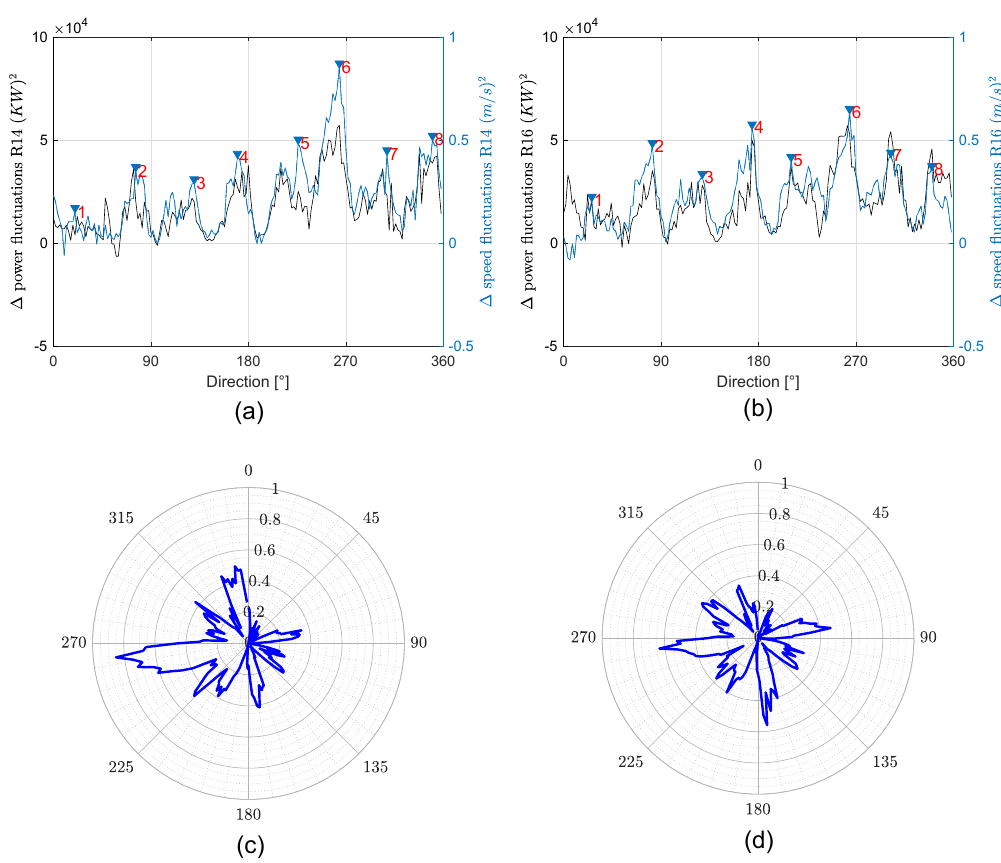
Figure 5. Mean fluctuation difference ( a,b ) between inner turbines and free-flow turbines for all wind directions and wind turbines R14 ( c ) and R16 ( d ), respectively. Left axis shows power fluctuations and right axis shows wind speed fluctuations. Polar plot of wind speed fluctuation difference for turbines R14 and R16, respectively. The radial axis is the difference of wind speed fluctuations [(m/s) 2 ] between inner turbine and a free-flow turbine.